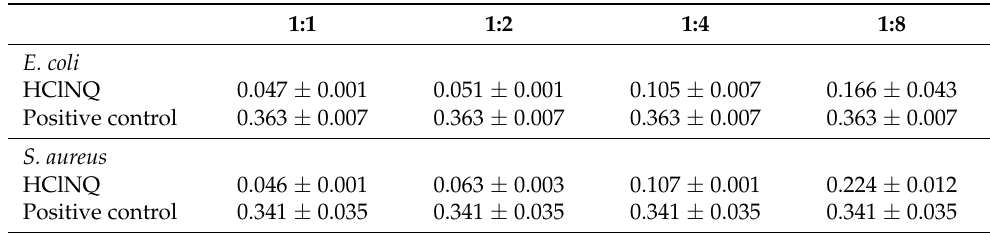
Table 5. MIC (minimal inhibition concentration) of tested complex HClNQ with dilution ratio. Values mean absorbance. Absorbance was based on the cloudiness of the sample. Higher value means that bacteria were growing. Positive control represents bacterial growth without any